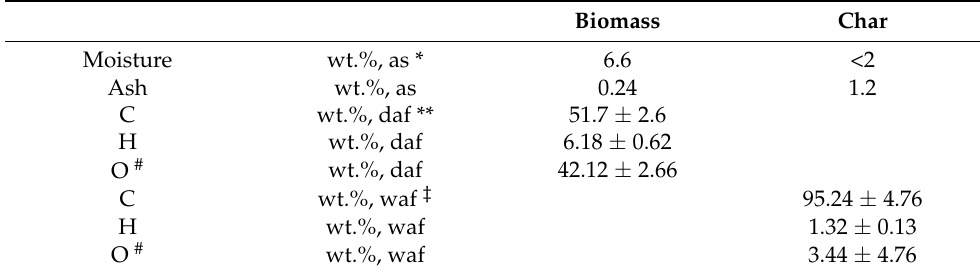
Table 2. Properties of raw biomass and